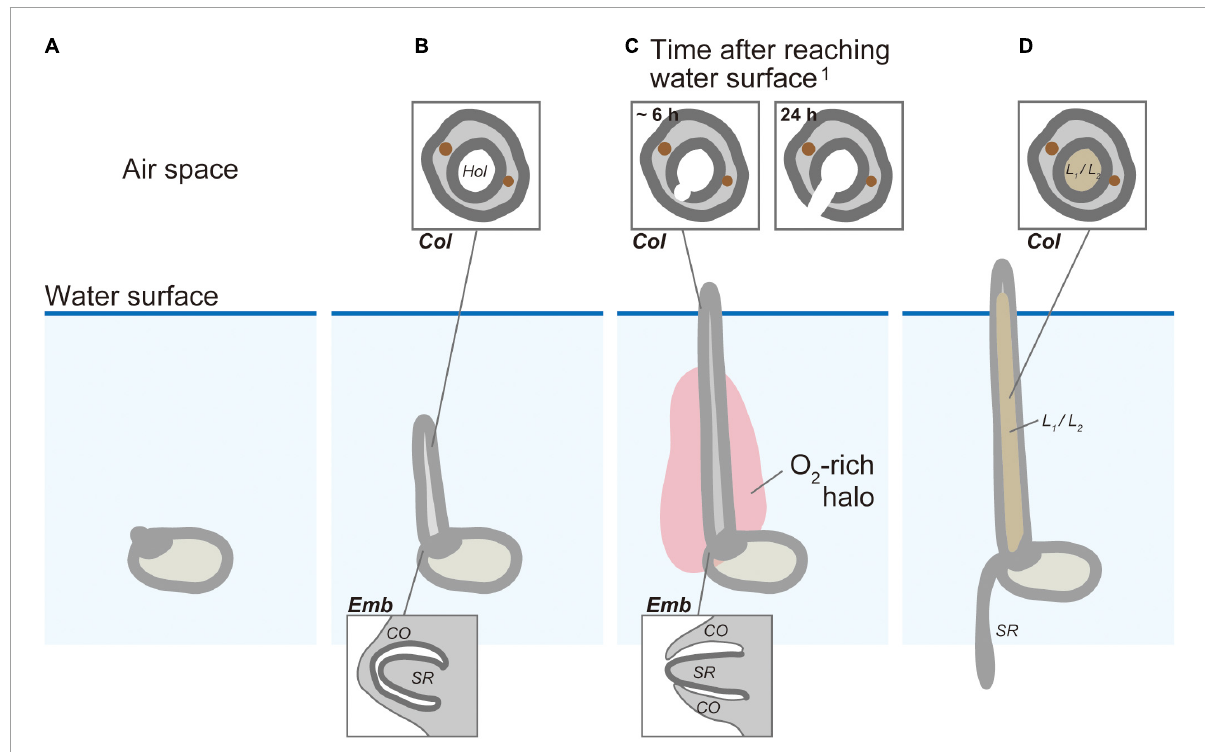
FIGURE7 The conceptual model of the snorkel effect during submerged rice germination. (A) Before coleoptile appearance. (B) Coleoptile tip underwater. (C) Coleoptile tip above water and before seminal root emergence. (D) Coleoptile tip above water and after seminal root emergence. Col , coleoptile; CO , coleorhiza; Emb , embryo; Hol , hollow; L 1 , 1st leaf; L 2 , 2nd leaf; SR , seminal root. 1 The timing of cell death after aeration was predicted based on previous research by Kawai and Uchimiya